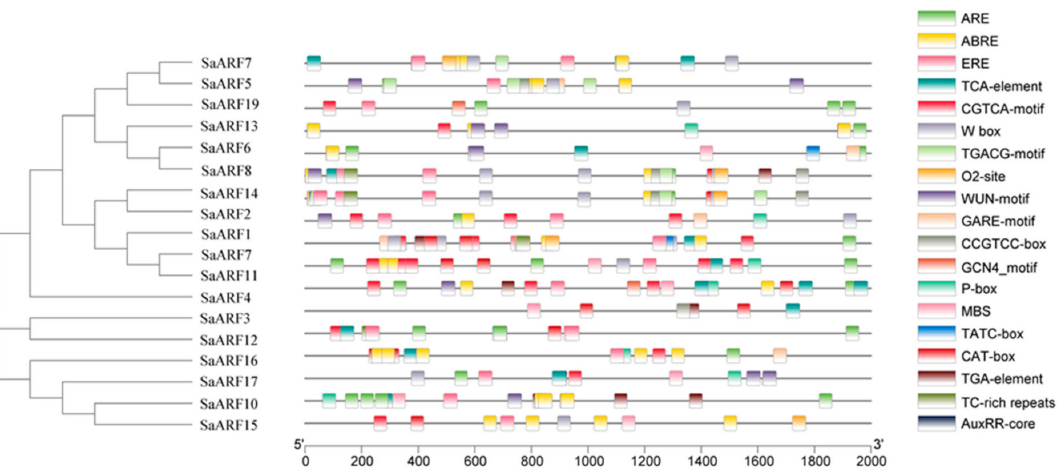
Figure 8. Distribution of cis-reactive elements in promoters of the SaARF gene family. There are 18 cis-reaction elements, including ARE, ABRE and ERE. ARE: anaerobic induction; ABRE: abscisic acid responsiveness; ERE: Estrogen Response Element; TCA-element: salicylic acid responsiveness; CGTCA-motif: MeJA-responsiveness; W-box: Trauma and pathogen reactivity; TGACG-motif: MeJA- responsiveness; O2-site: zein metabolism regulation; WUN-motif: wound-responsive element; GARE- motif: gibberellin-responsive element; CCGTCC-box: Meristem specific activation; GCN4-motif: endosperm expression; P-box: gibberellin-responsive element; MBS: MYB binding site involved in drought-inducibility; TATC-box: gibberellin-responsiveness; CAT-box: meristem expression; TGA- element: auxin-responsive element; TC-rich repeats: defense and stress responsiveness;